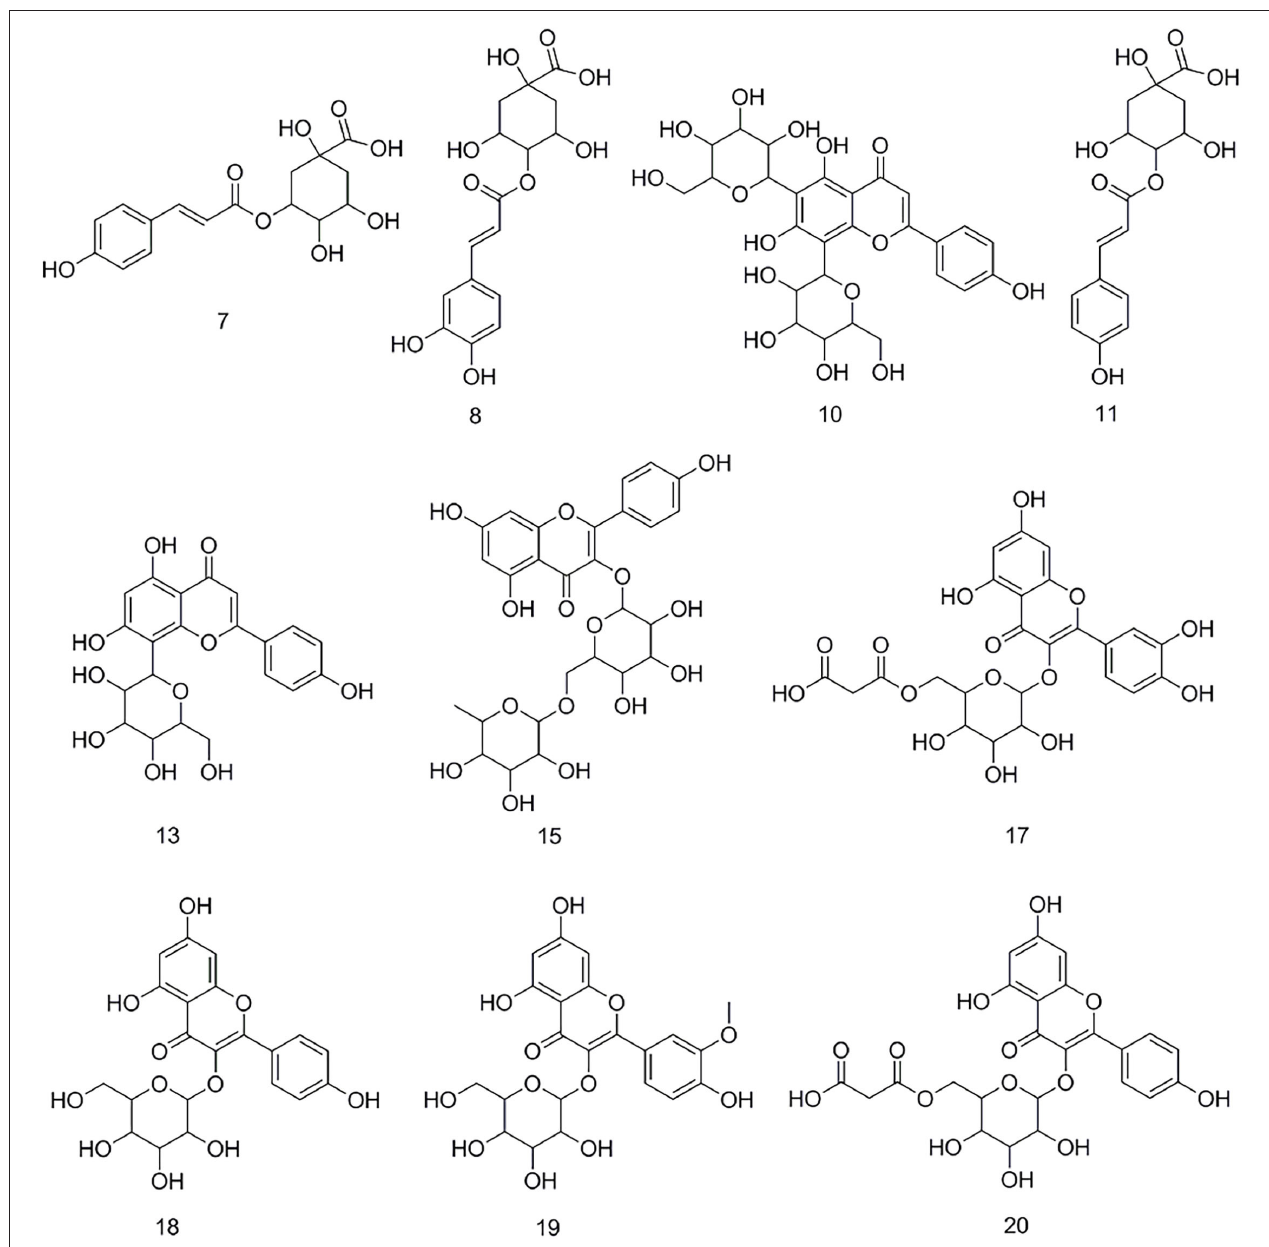
FIGURE 3 | The representative bioactive compounds figured out and identified in M. oleifera leaf